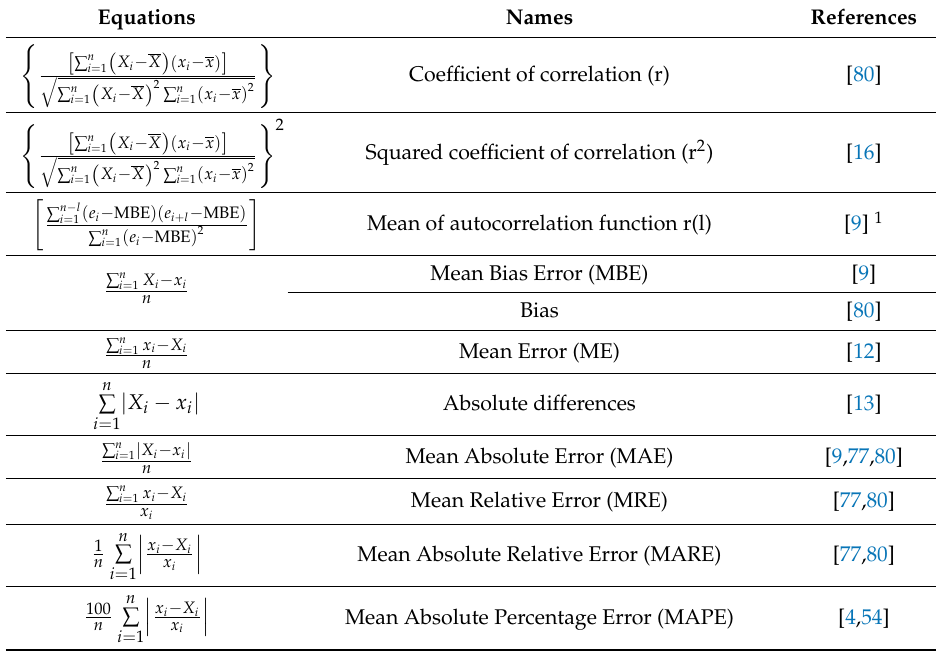
Table 1. Criteria used to evaluate performance of interpolation methods found in literature.